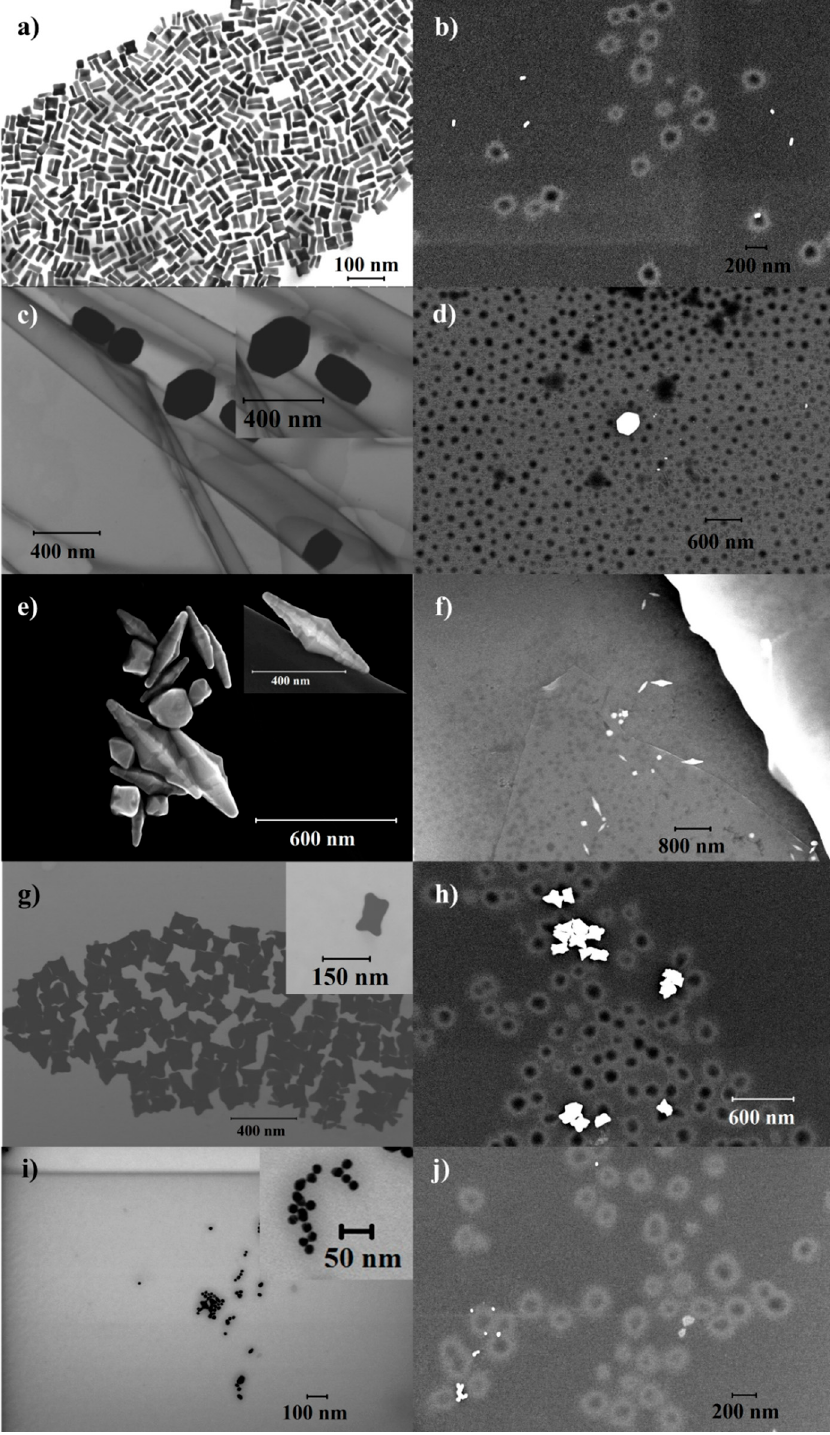
Figure 1. S(T)EM images of ( a ) AuNR, ( b ) PEG-hydrogel coated AuNR, ( c ) AuHex, ( d ) PEG-hydrogel coated AuHex, ( e ) AuBP, ( f ) PEG-hydrogel coated AuBP, ( g ) AuNM, ( h ) PEG-hydrogel coated AuNM, ( i ) AuNS, and ( j ) PEG-hydrogel coated AuNS.